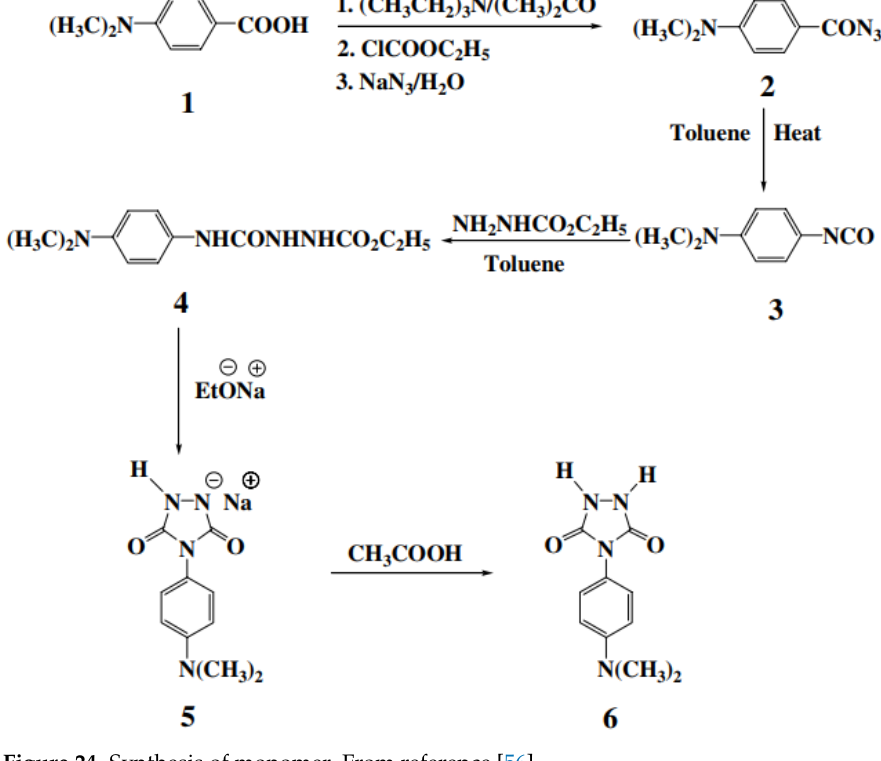
Figure 24. Synthesis of monomer. From reference [56].